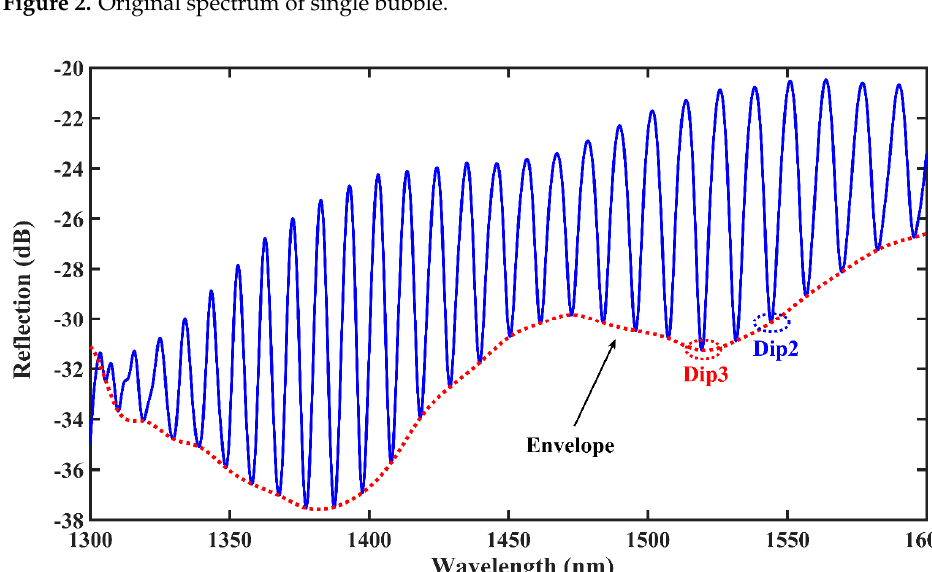
Figure 3. Original spectrum of double bubbles.